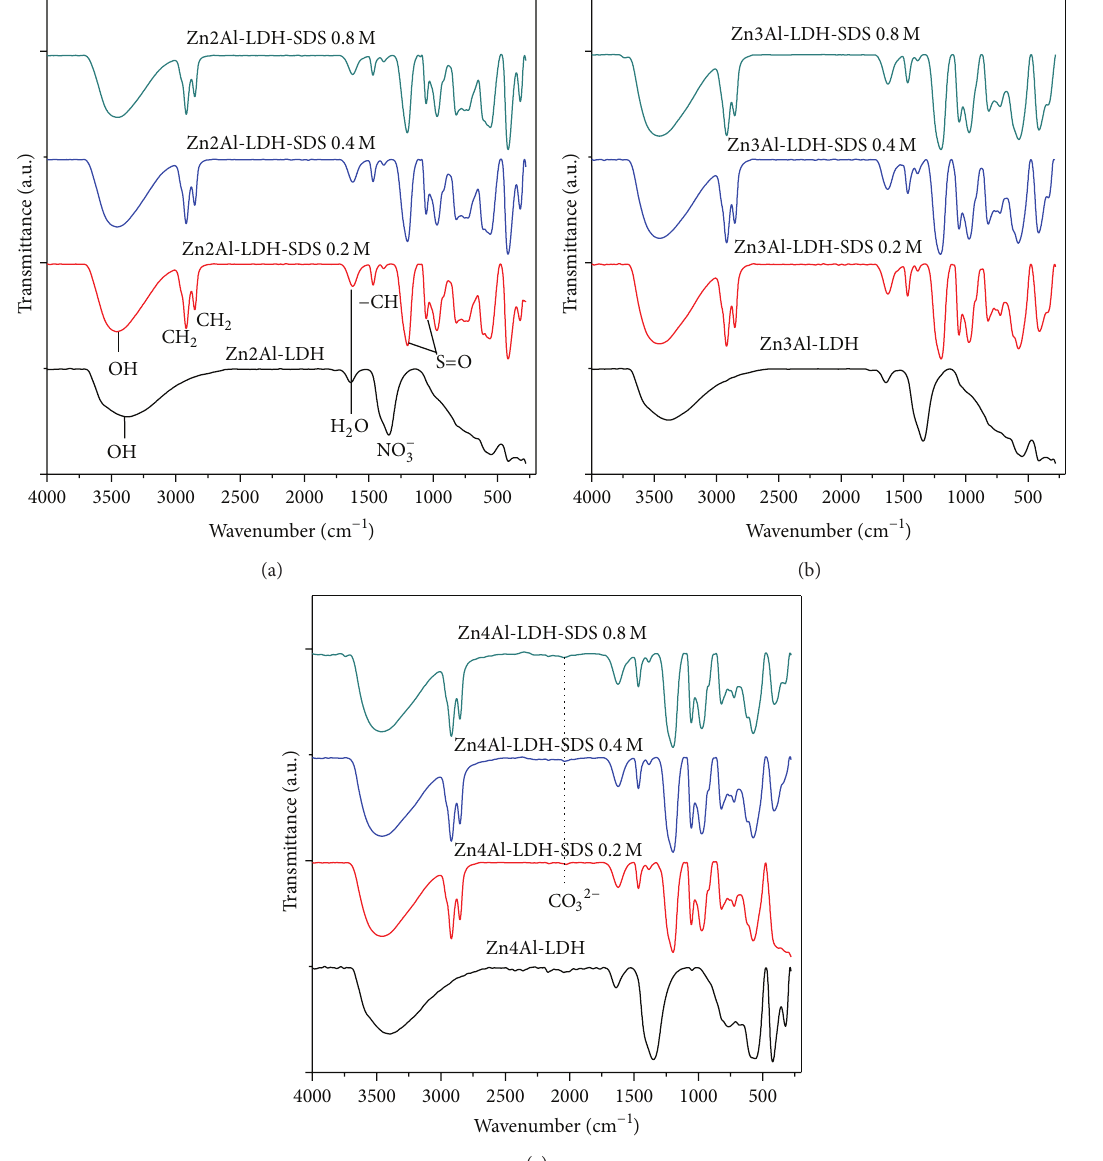
be used to calculate the interlayer spacing: 𝑐 = (1/3) (3 d